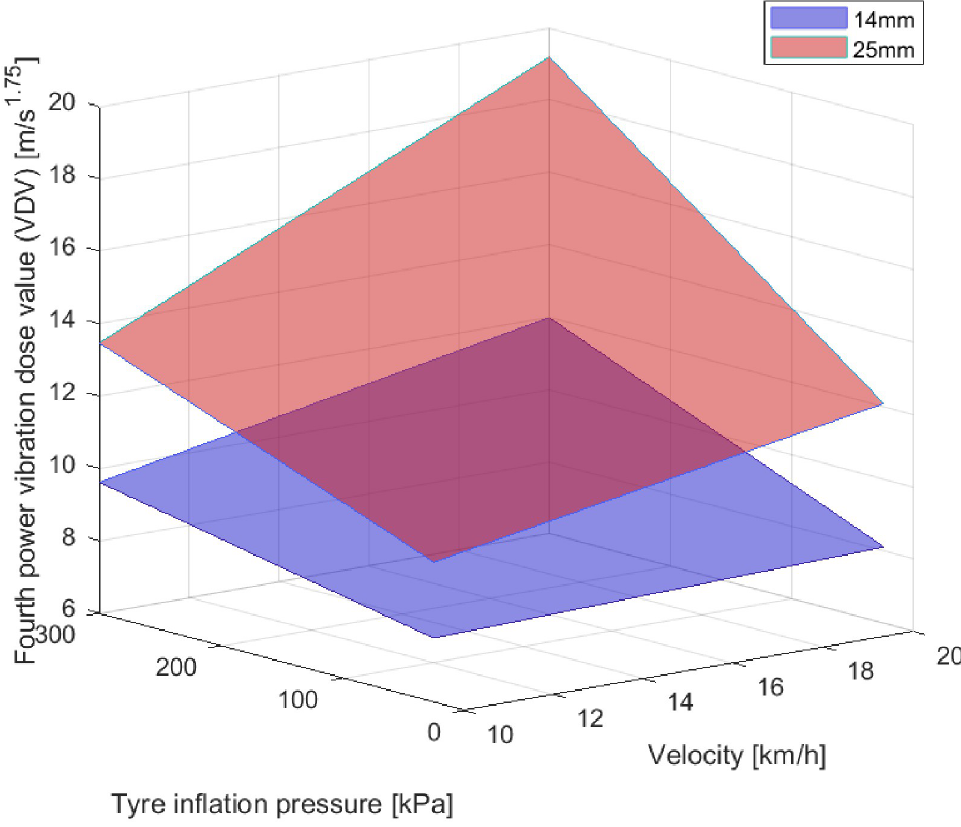
Fig 7. Fourth power vibration dose value (VDV) in accordance to ISO 2631 over tyre inflation pressure and vehicle speed. The graph visualises the measurement results of the bicycle trailer over a step (height 14mm resp. 25mm).